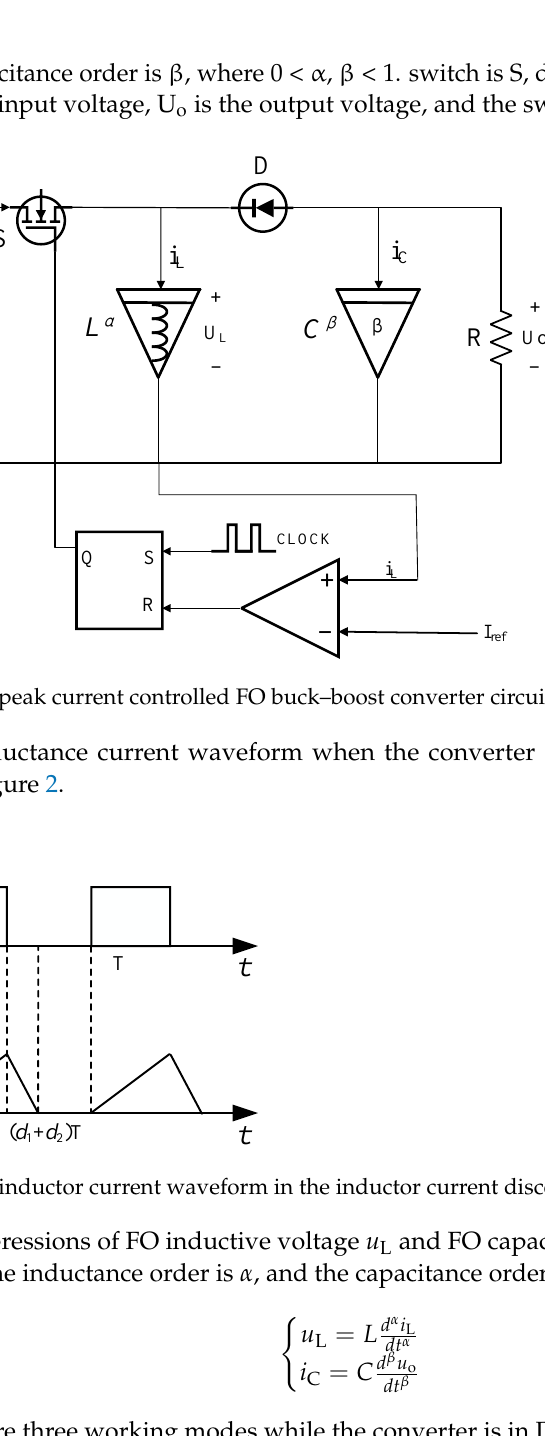
There are three working modes while the converter is in DCM mode. Mode 1( n T < t < ( n + d 1 )T): the switch S is open and the diode D is closed